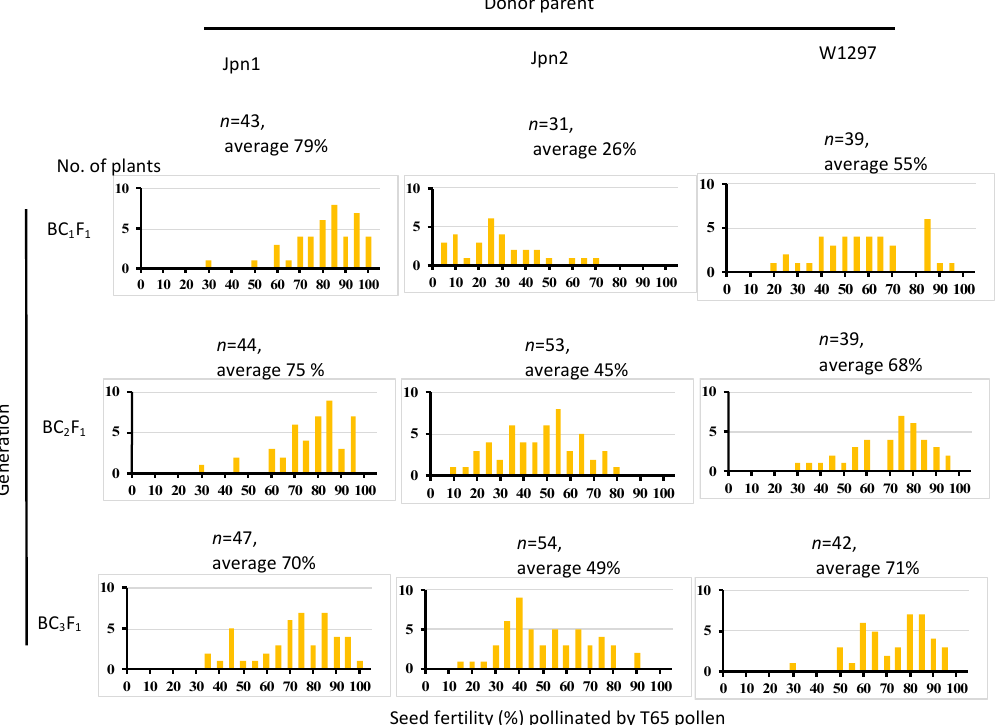
Figure 4. Seed fertility pollinated by T65 of backcross generation using Jpn1, Jpn2 and W1297 as donor parents and T65 as the recurrent parent.